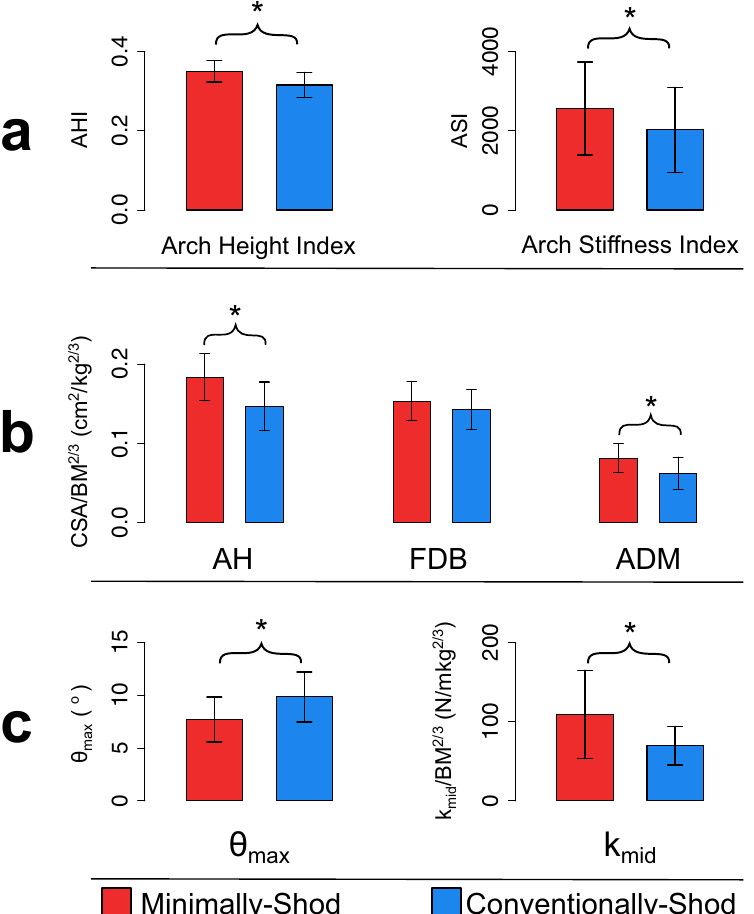
Figure 4. Results of comparisons between minimally- and conventionally-shod individuals. ( a ) Static measurements of arch height index (AHI) and arch stiffness index (ASI). ( b ) Muscle cross-sectional area (CSA) measurements. Note that values are scaled by (body mass [BM]) 2/3 . ( c ) Dynamic measurements of maximum arch deformation angle ( θ max ) and arch stiffness (k mid ). Note that k mid is scaled by (body mass) 2/3 . * denotes statistically significant difference between groups.